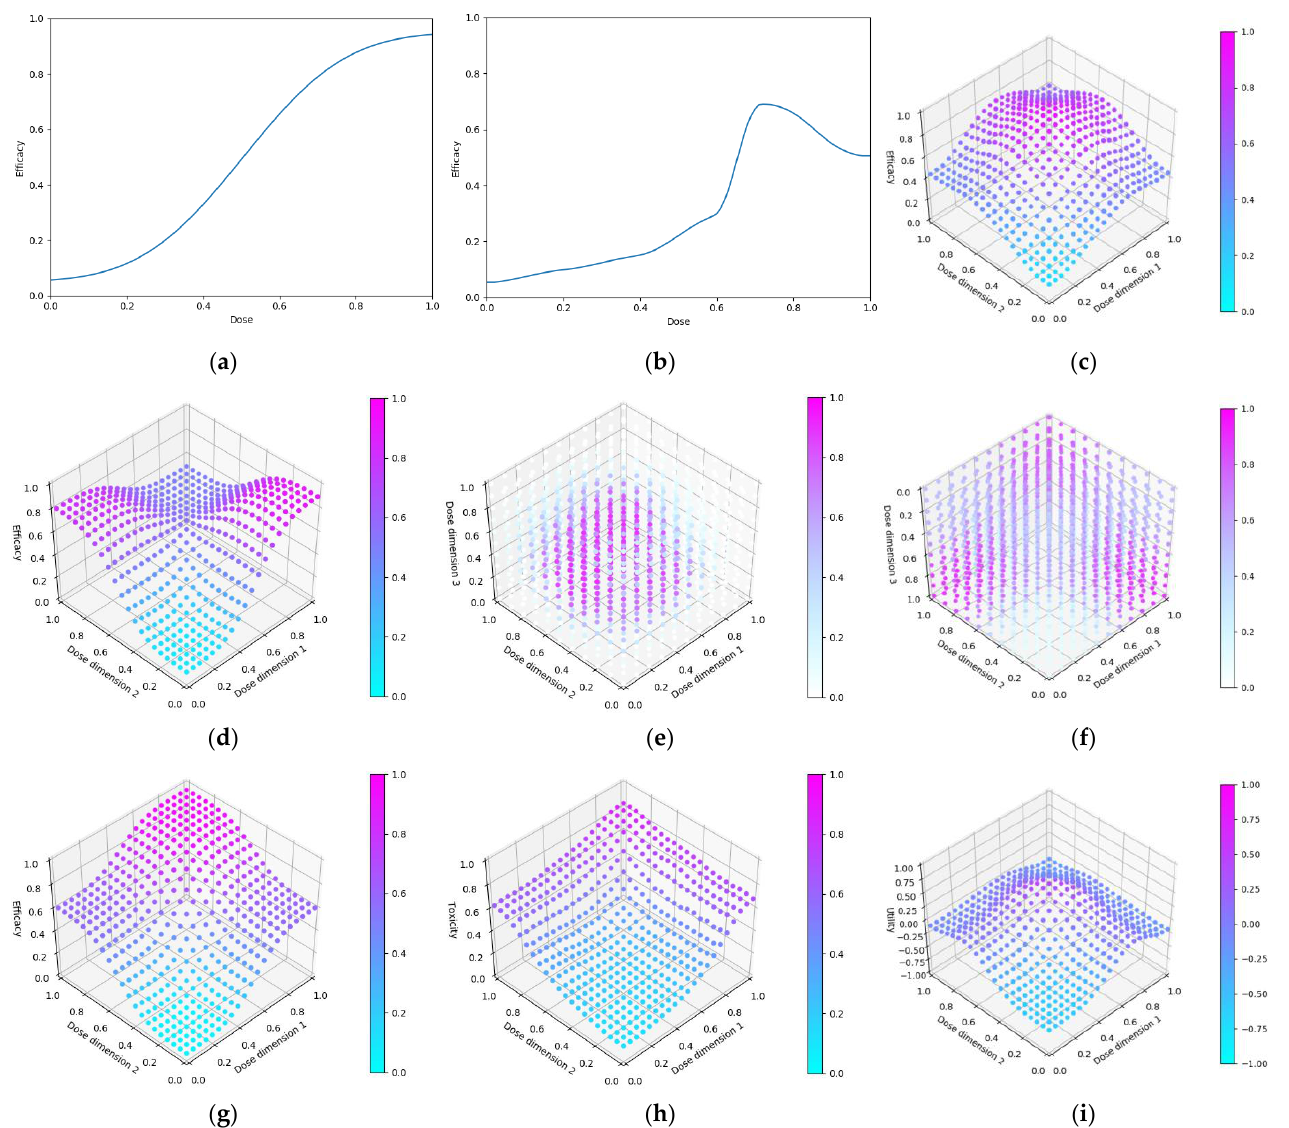
Figure 9. Dose efficacy and efficacy/toxicity/utility plots for the seven objective 4 scenarios. Dose-efficacy plots were ( a ) scenario 1, ( b ) scenario 2, ( c ) scenario 3, ( d ) scenario 4, ( e ) scenario 5, ( f ) scenario 6. For ( g – i ) scenario 7, these were, respectively, for efficacy/toxicity/utility. ( a , b ) The blue line represents the probability of efficacious/toxic response and utility for each dose. ( c – i ) Purple represents areas of higher efficacy/toxicity/utility.